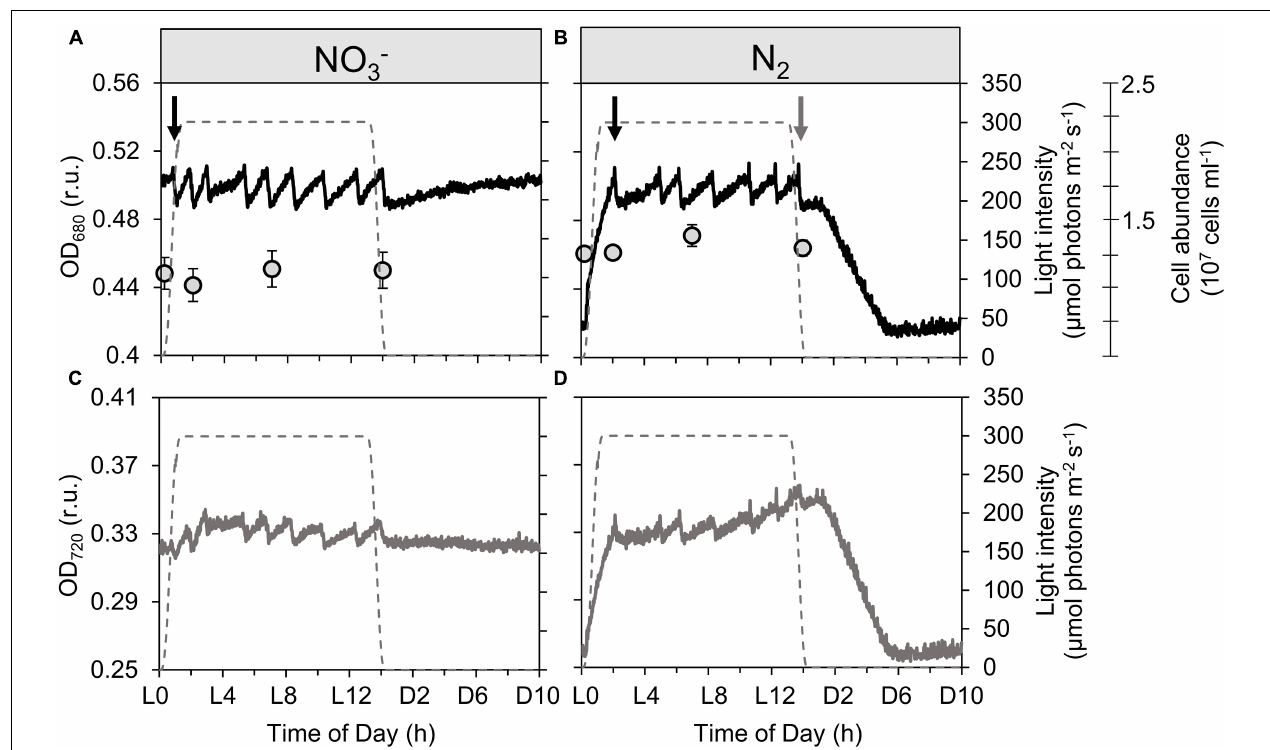
FIGURE 1 | Record of dynamics in optical density measured at 680 nm [black lines; OD 680 , (A,B) ] and 720 nm [gray lines; OD 720 , (C,D) ] together with cell abundance [gray circles; (A,B) ] of Cyanothece turbidostat cultures cultivated in ASP 2 medium supplemented with NO 3 − (A,C) and under obligate diazotrophy (B,D) . The OD 680 (more sensitive to changes in Chl a content) and OD 720 (more sensitive to changes in non-pigment biomass) signals are measured within the photobioreactor vessel and represent a typical record of optical density over a diel cycle. The cell abundance data are averages from 9 samples from 3 independent bioreactors for each treatment; error bars show standard deviations. The gray dashed lines show the light profile throughout the day. Black arrows point to the first culture dilution event at the beginning of each light phase, while the gray arrow points to the last dilution event in the N 2 -fixing culture.